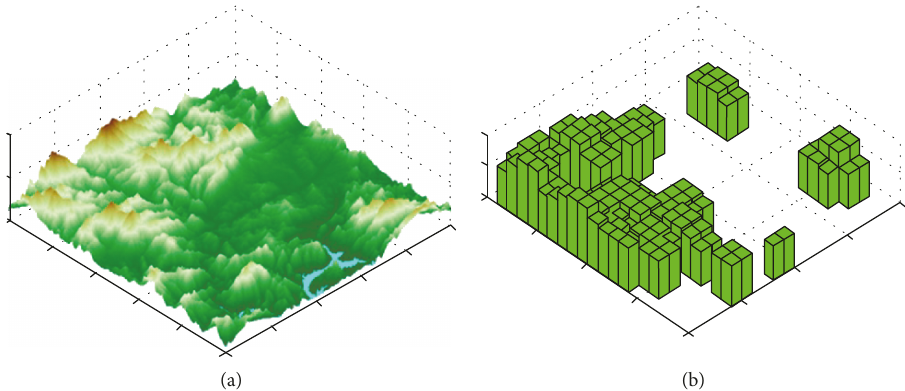
Figure 1: Modeling of SUAV operating environment: (a) sample of digital moving map in 1 kilometer square; (b) generated convex modeling of obstacles based on a given